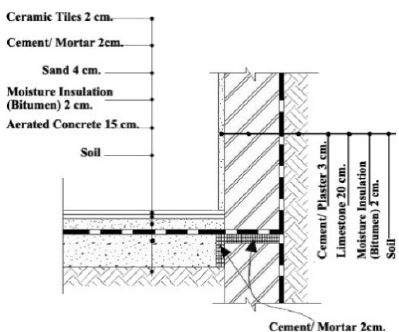
Figure 8. Cross-section of the calibrated basement floor and slab